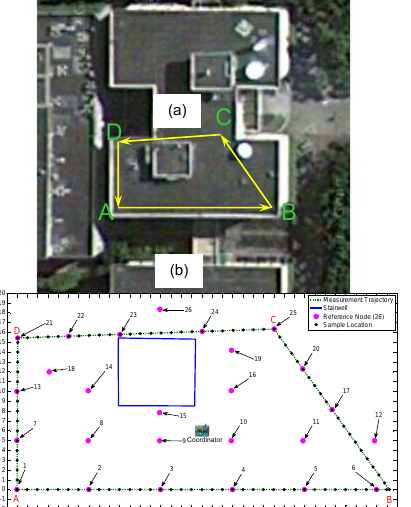
Figure 3. The floor layout of the experimental